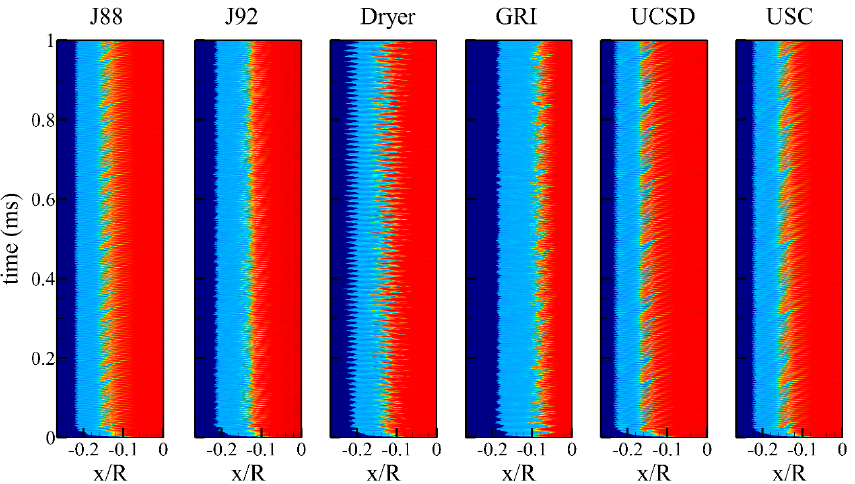
as Figure 9. All the reaction mechanisms, except Jachimowski-92 and GRI mechanisms, produce a regular oscillation at base grid resolution. Firstly, GRI mechanism predicts low ignition delay times from the CV explosion model for this initial condition. As a result, the resulting flow field predicts a longer induction zone and, hence, the resulting flow field oscillation is low when compared to the experimental frequency. With the increase in grid resolution, the reaction mechanism does not show any significant difference in the prediction and always predicts a low-frequency oscillation. Secondly, the Jachimowski-92 mechanism predicts a low-frequency oscillation along with a regular oscillation even at reactions are suppressed, and the resulting flow field predicts a regular oscillation with few disturbances. With further increase in the grid resolution, the low-frequency oscillation supersedes the regular oscillation and, finally, results in a high-amplitude low-frequency oscillation. The evolution of the flow field from 0.25 ms to 0.4 ms is extracted for all the grid systems with the Jachimowski-92 mechanism, as shown in Figure 14. all the grid systems with the Jachimowski-92 mechanism, as shown in Figure 14.